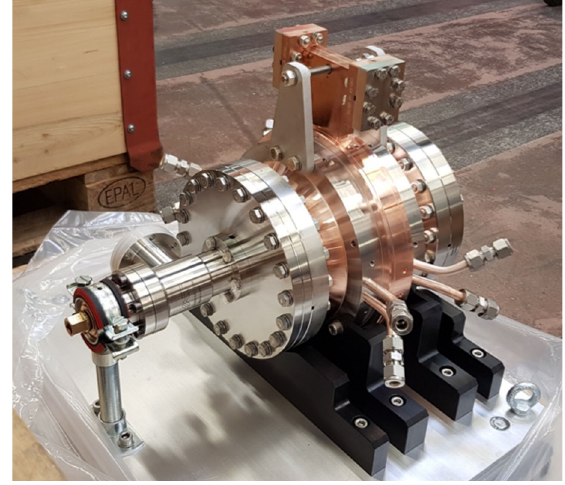
FIG. 4. XBOC prototype.